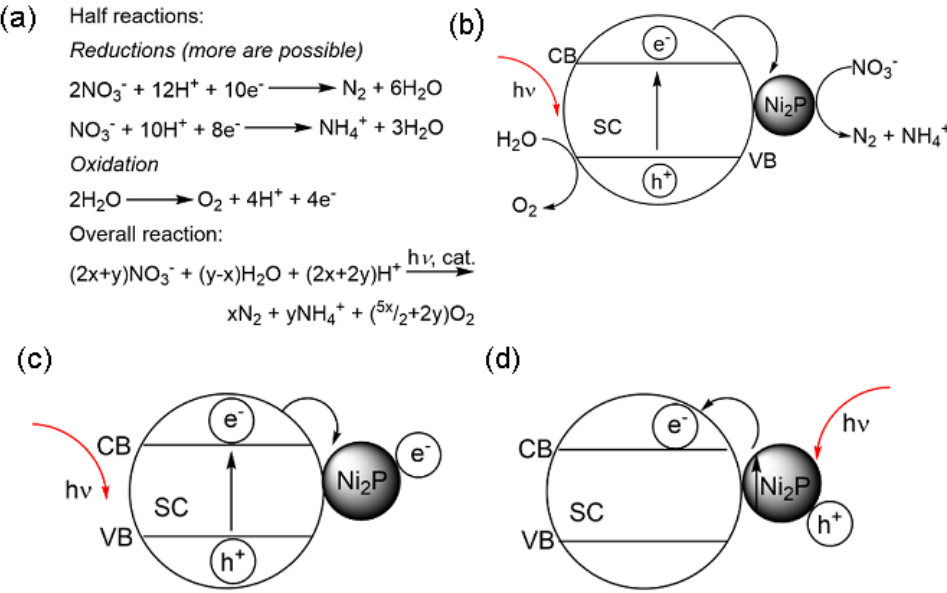
Figure 15. ( a ) Half and overall reactions for photocatalytic reduction of NO 3 − to the most desirable product(s) N 2 and/or NH 3 . ( b ) Mechanistic scheme showing energy flow during the photocatalytic reduction of NO 3 − over a Ni 2 P-modified semiconductor. ( c , d ) Schematic illustrations of two possible charge separation pathways during photocatalysis. In mechanism ( a ), light absorption by the semiconductor results in photo-generated electrons and holes, with the electrons getting trapped by Ni 2 P. The resulting Ni 2 P Fermi level upshift leads to a higher driving force for NO 3 − reduction. In mechanism ( b ), photogenerated “hot” electrons from Ni 2 P are injected into the semiconductor. Reproduced and adapted with permission from ref. [181]. Copyright 2020 John Wiley and Sons.